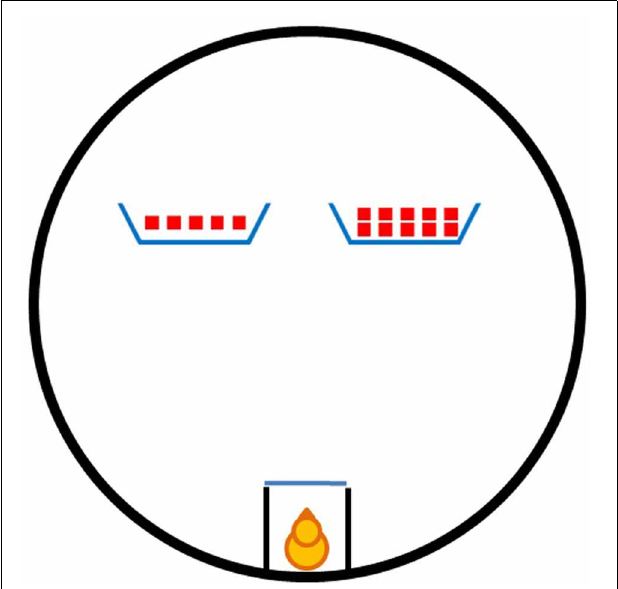
FIGURE 1 | The apparatus employed in both experiments. The holding box and the two screens are here represented in the arena just as they were during the testing